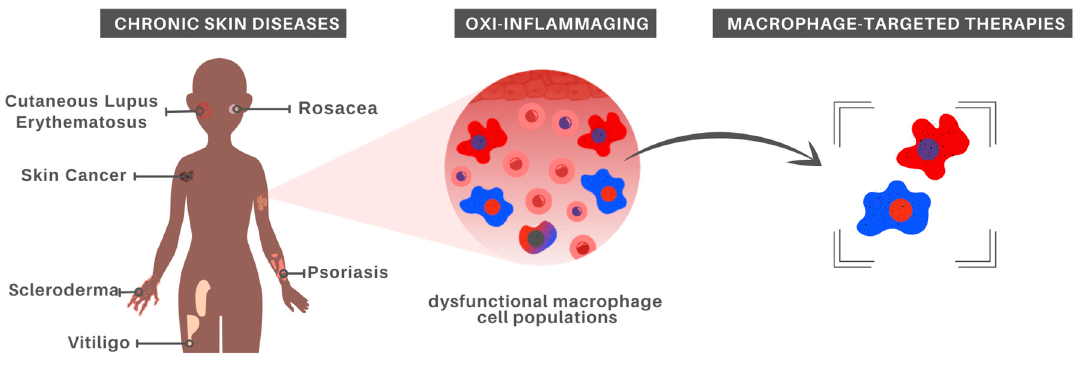
Figure 2. Macrophage-centered approaches for chronic skin disease treatment. In recognition of the major role played by aged M ϕ in oxi-inflammaging, which in turn has been recognized as a risk factor for the development of chronic inflammatory skin diseases, it is possible that M ϕ -targeted therapies constitute a promising alternative for at least some inflammatory skin